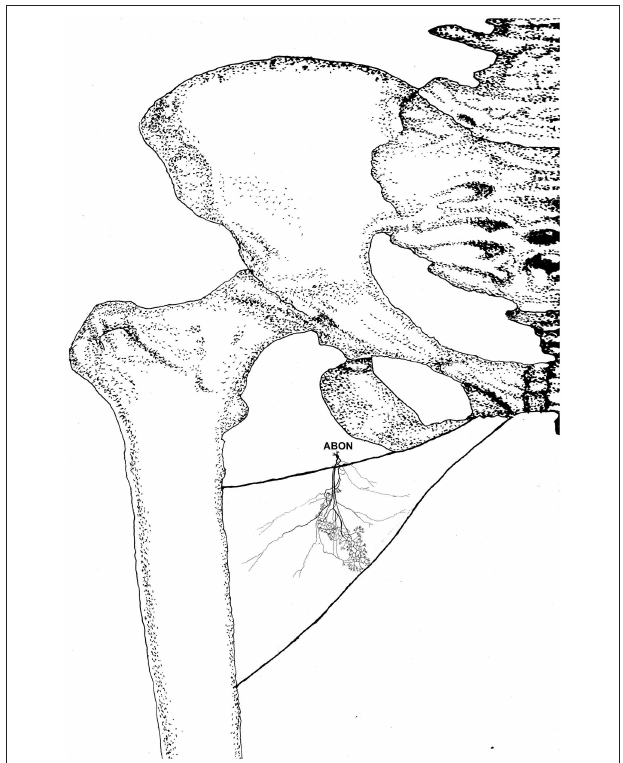
FIGURE 4 | Three dimensional pattern of intramuscular nerve distribution in the adductor brevis (right, superficial side; ABON, anterior branch of the obturator